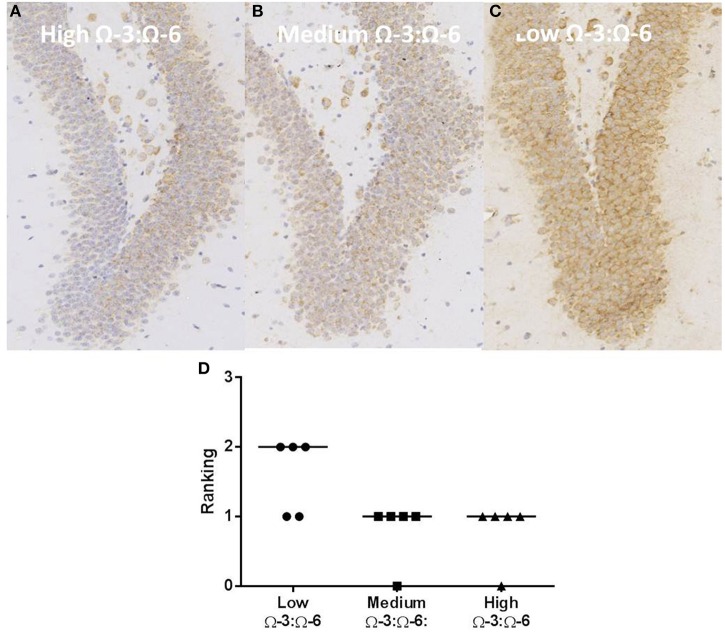
Effect of Ω-3:Ω-6 diet on oxidative stress in the dentate gyrus. Representative images of oxo8dG/oxo8G expression in the dentate gyrus at 20× magnification in (A) high Ω-3:Ω-6 mice, (B) medium Ω-3:Ω-6 mice, (C) low Ω-3:Ω-6 mice, with representation of the median intensity of staining in each group (D).